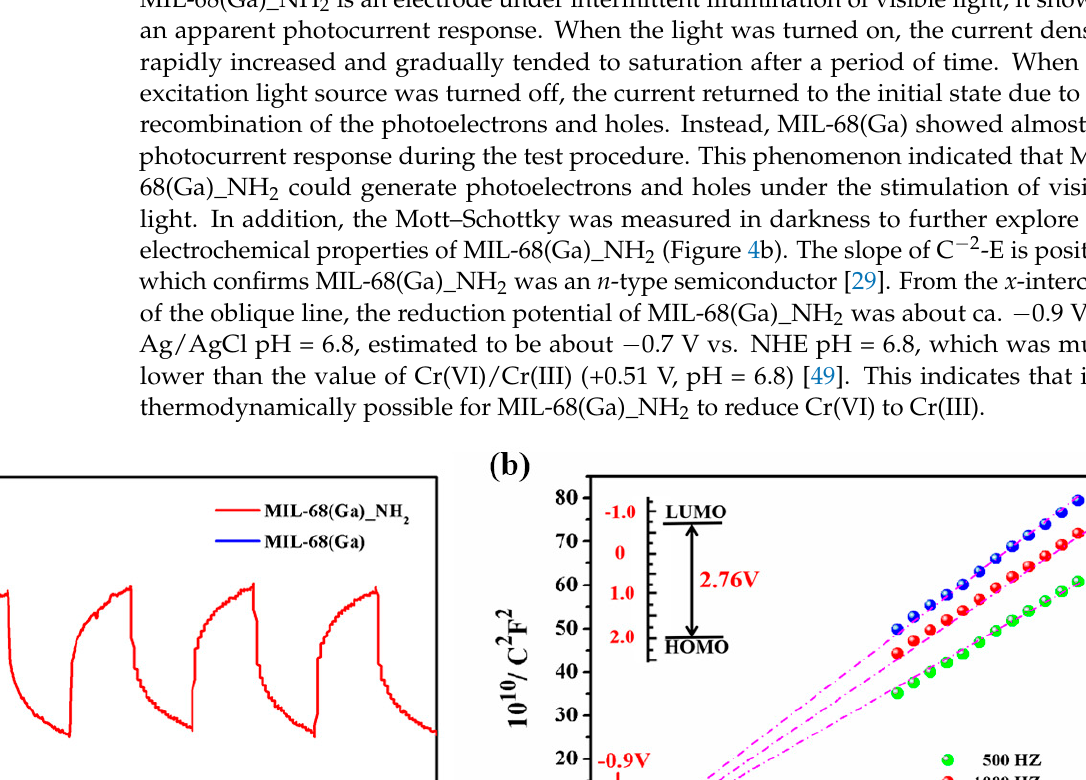
Figure 3. UV-vis DRS of MIL–68(Ga)_NH 2 (black), MIL–68(Ga) (blue) and H 2 BDC_NH 2 (red). The insets are the photographs of ( a ) MIL–68(Ga) and ( b ) MIL–68(Ga)_NH 2 samples.